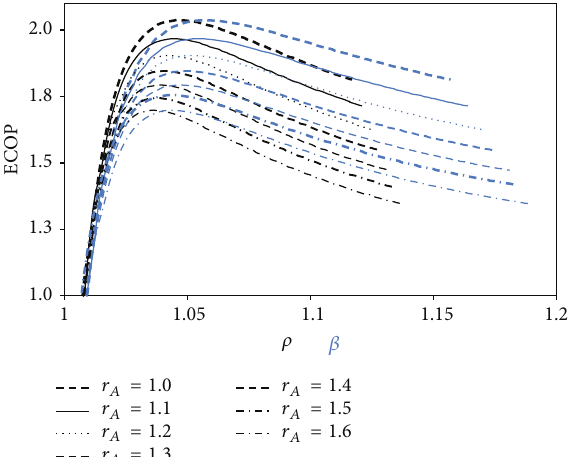
Figure 8: 𝜏 versus 𝑟 𝐴 at ECOP for different 𝐼 Δ𝑆 values ( 𝑇 0 = 𝑇 𝐿 = 300 K, 𝛼 = 17𝑋 = 0.3 , and 𝜉 = 0.02